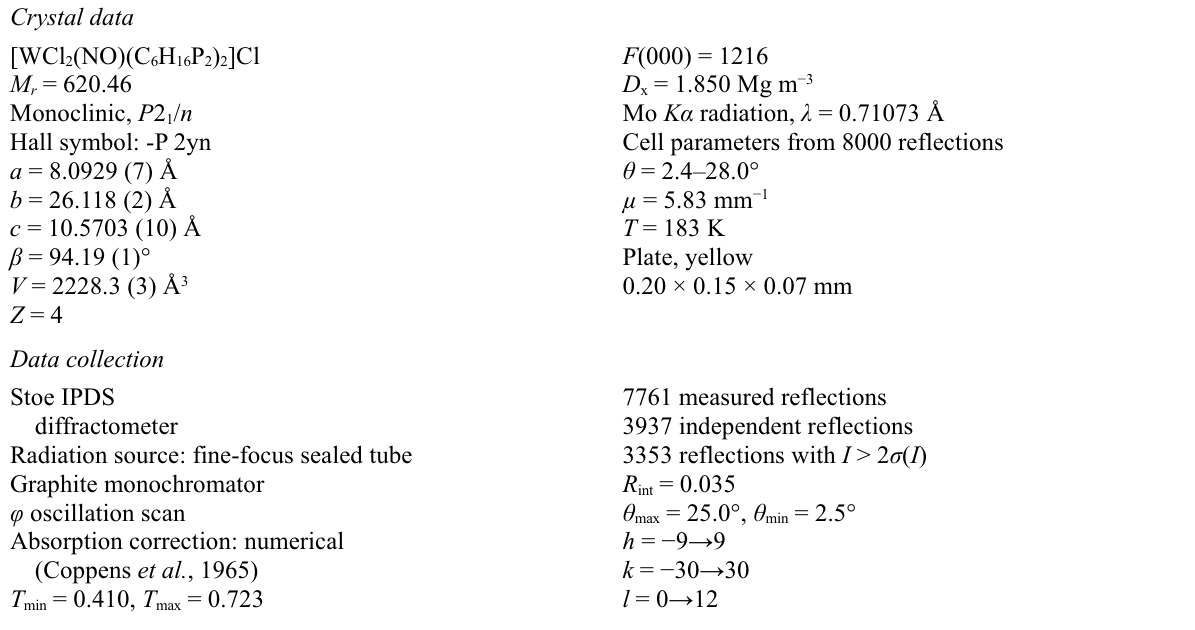
View of the molecular structure of (I) with the atom-labeling scheme (displacement ellipsoids are drawn at the 30% probability level). The disordered atoms N12, O12 and Cl22, and all hydrogen atoms have been omitted for clarity. Bis[1,2-bis(dimethylphosphino)ethane]dichloridonitrosyltungsten(0)